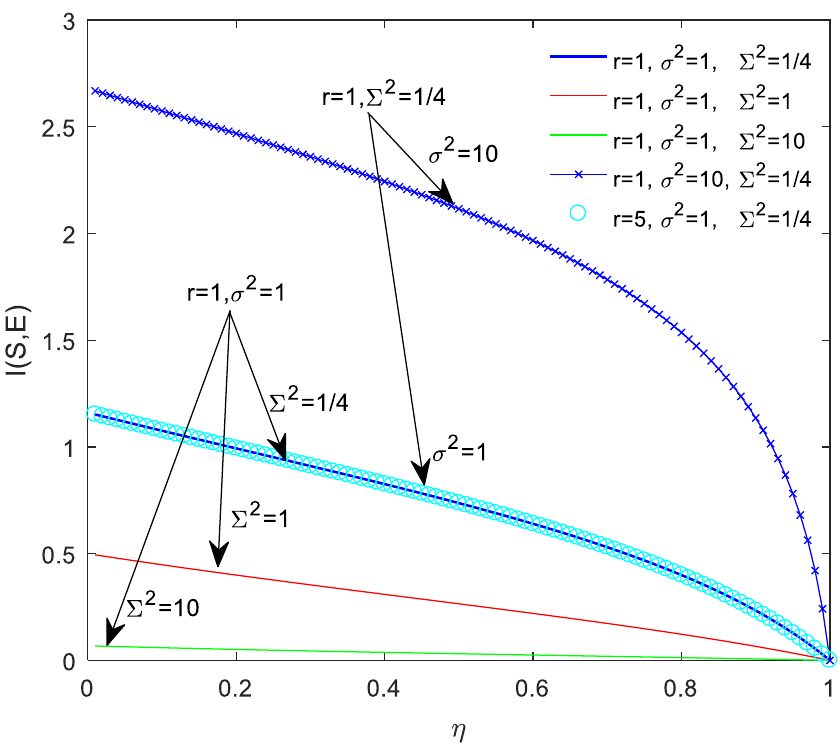
Figure 5. The mutual information of